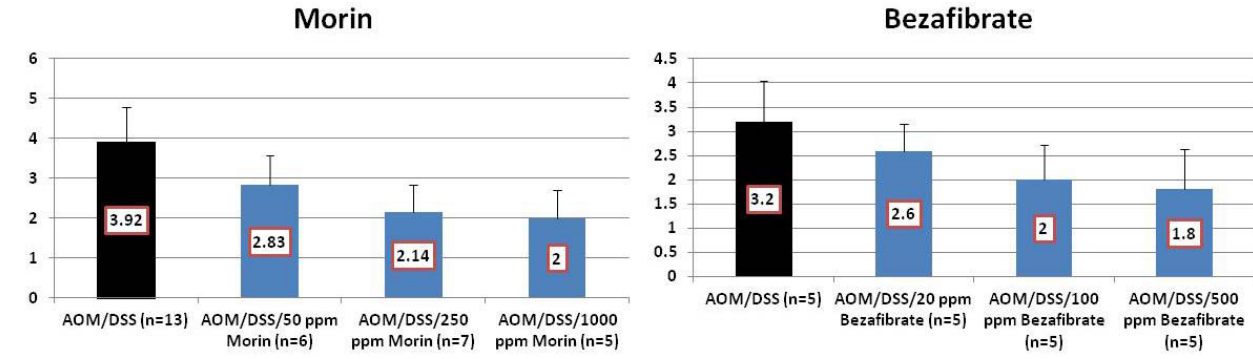
Figure 12. mRNA expression of Stat3 in the colorectum of mice or rats from the morin, bezafibrate, and VPA